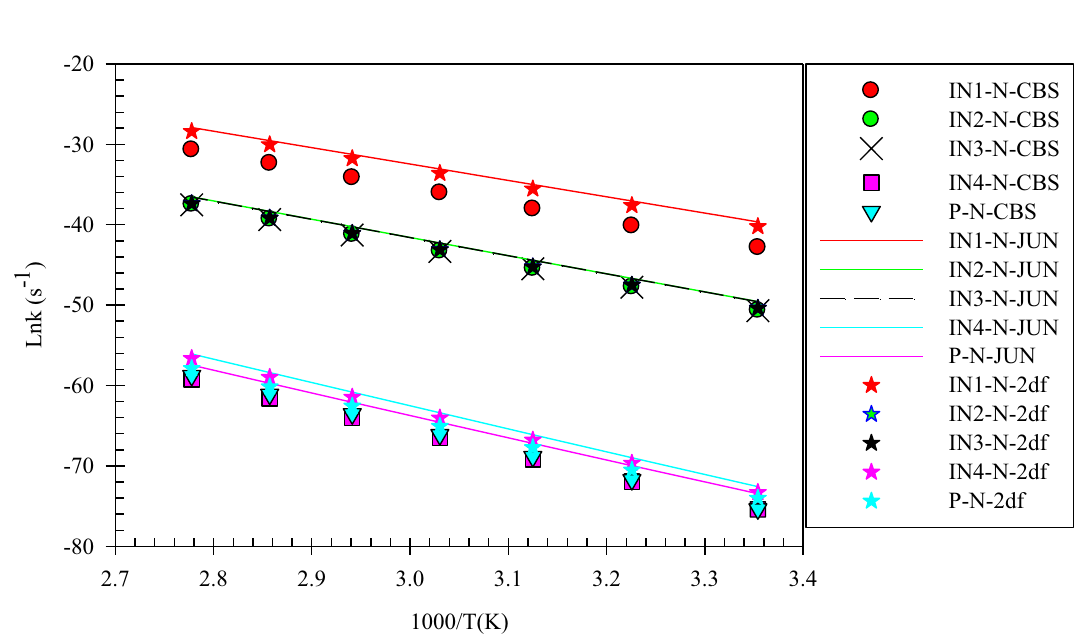
Figure 3. Overall rate constants for production of all minimum stationary points in 3-hydroxyl-1H-pyrrol- 2(5H)-one unimolecular reaction calculated at three different levels over 298.15–360 K temperature